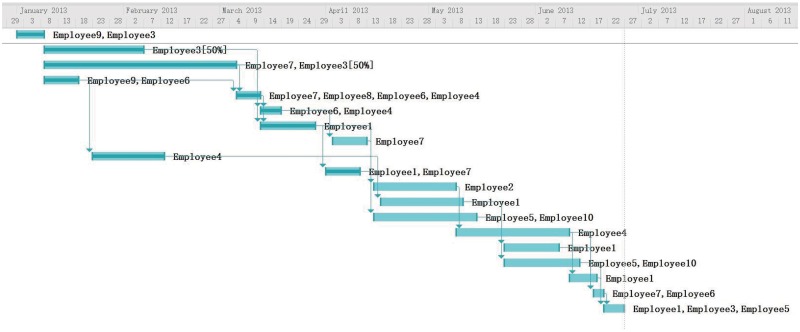
Rescheduling Result from Expert 2.